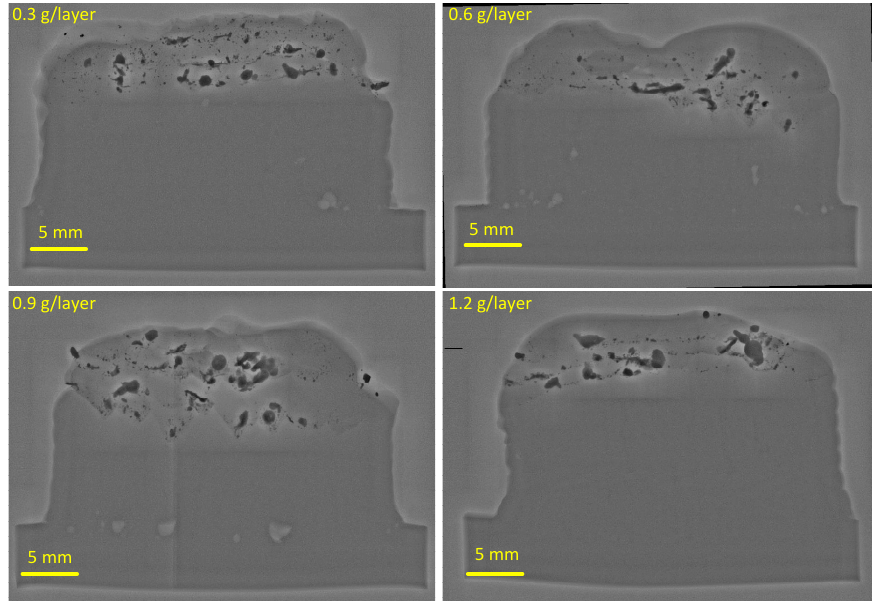
Figure 3. X-ray tomography cross section positive images of the Zone 2 structures as-viewed from the direction parallel to that of layer deposition. Dark and light-grey areas reveal Mo-rich areas and pores, respectively.